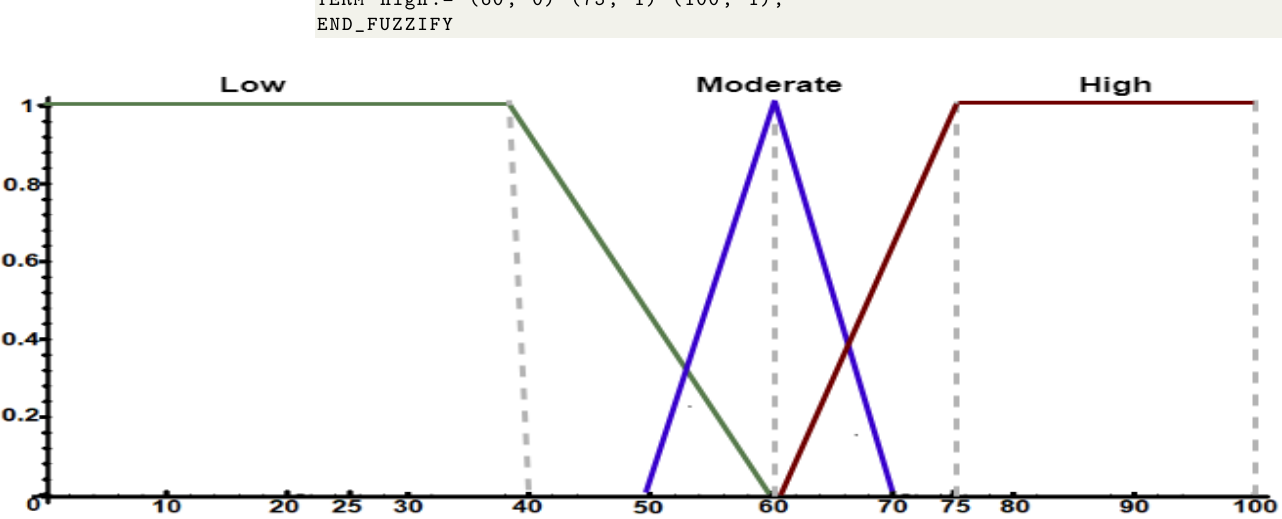
Figure 6. Fuzzy sets to model the similarity levels between patterns and behaviors.